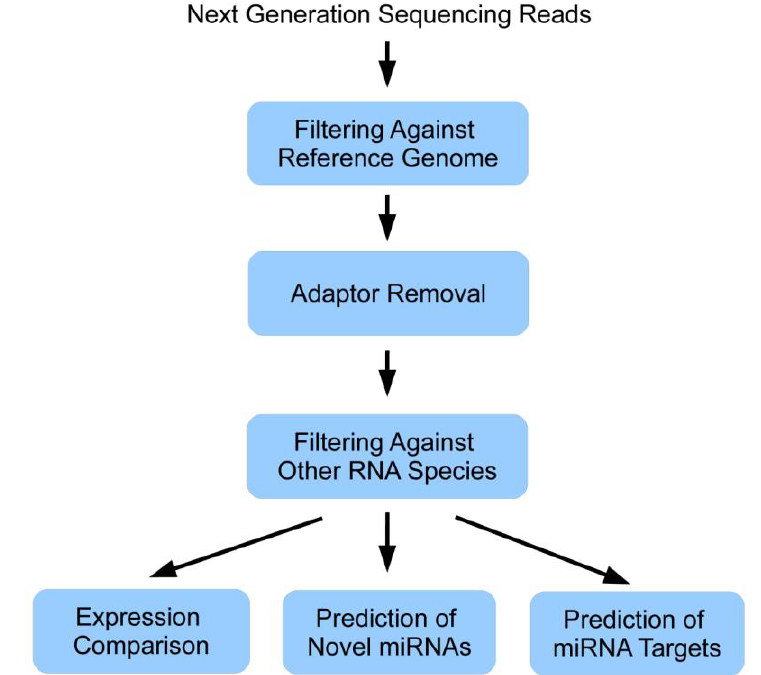
Figure 4. General data analysis workflow of a miRNA next generation sequencing